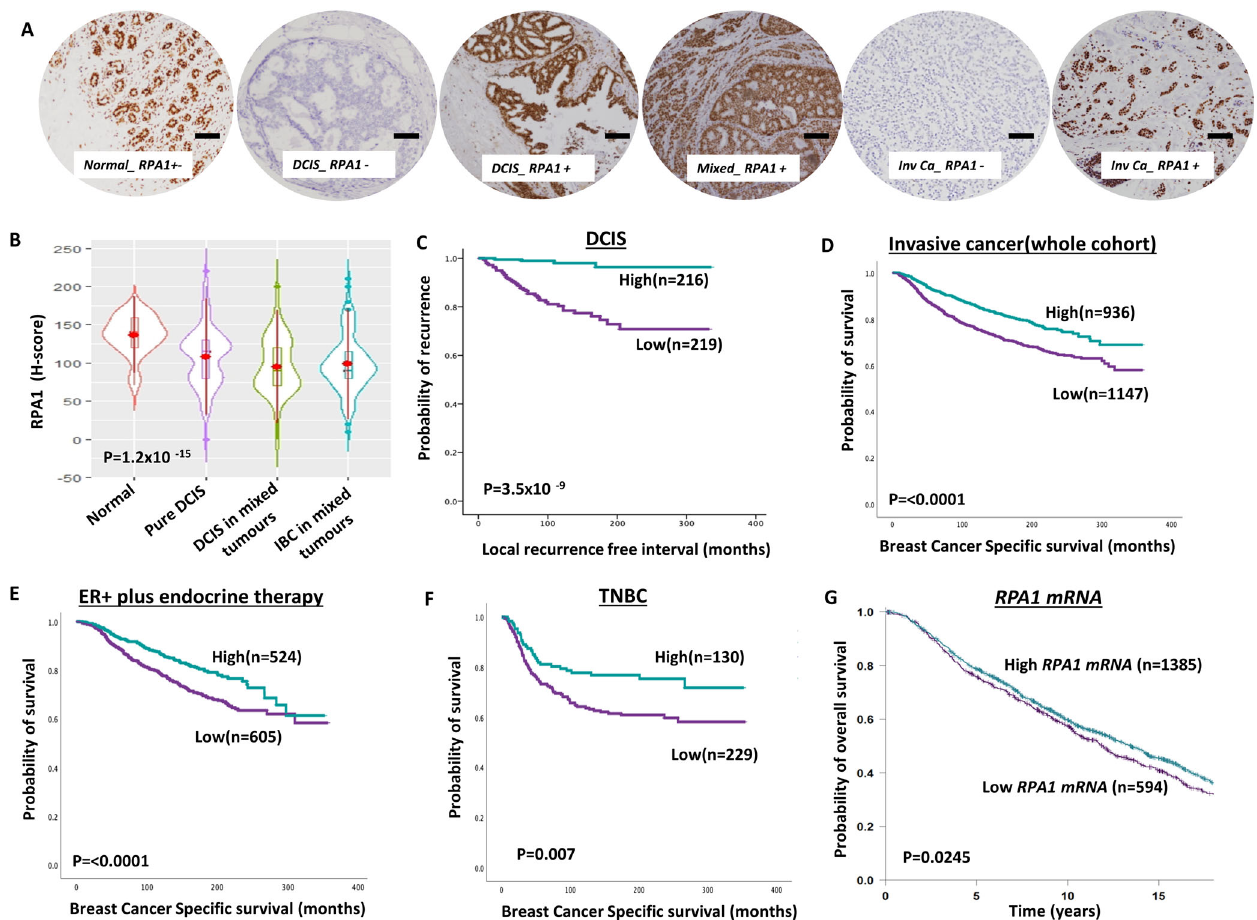
Fig. 1 Clinicopathological studies of RPA1 expression in breast cancers. A Photomicrographs showing immunohistochemical staining of RPA1 in breast cancers (scale bar “ − ” = 100 µM). B Violin plot shows the mean of RPA1 expression in normal, pure DCIS and DCIS mixed tumours [The red dot represents the median, open red bar in the center represents the interquartile range, the thin red line represents the rest of the distribution, except for points that are “ outliers ” . On each side of the red line is a kernel density estimation to show the distribution shape of the data. Wider sections of the violin plot represent a higher probability that members of the population will take on the given value; the skinnier sections represent a lower probability.]. C Kaplan – Meier curve for RPA1 nuclear protein expression and recurrence-free interval (LRFI) in DCIS ( D ) a Kaplan – Meier curve for RPA1 nuclear protein expression and breast cancer-speci fi c survival (BCSS) in the whole cohort. E Kaplan – Meier curve for RPA1 nuclear protein expression and BCSS in ER + cohort with endocrine therapy. F Kaplan – Meier curve for RPA1 nuclear protein expression and BCSS in triple negative (TN) in the whole cohort. G Kaplan – -Meier curve for RPA1 mRNA expression and breast cancer-speci fi c survival (BCSS) in the whole cohort. Survival rates were determined using Kaplan – Meier method and compared by the log- rank test. All analyses were conducted using Statistical Package for the Social Sciences (SPSS, version 22, Chicago, IL, USA) software for windows. P value of less than 0.05 was identi fi ed as statistically signi fi